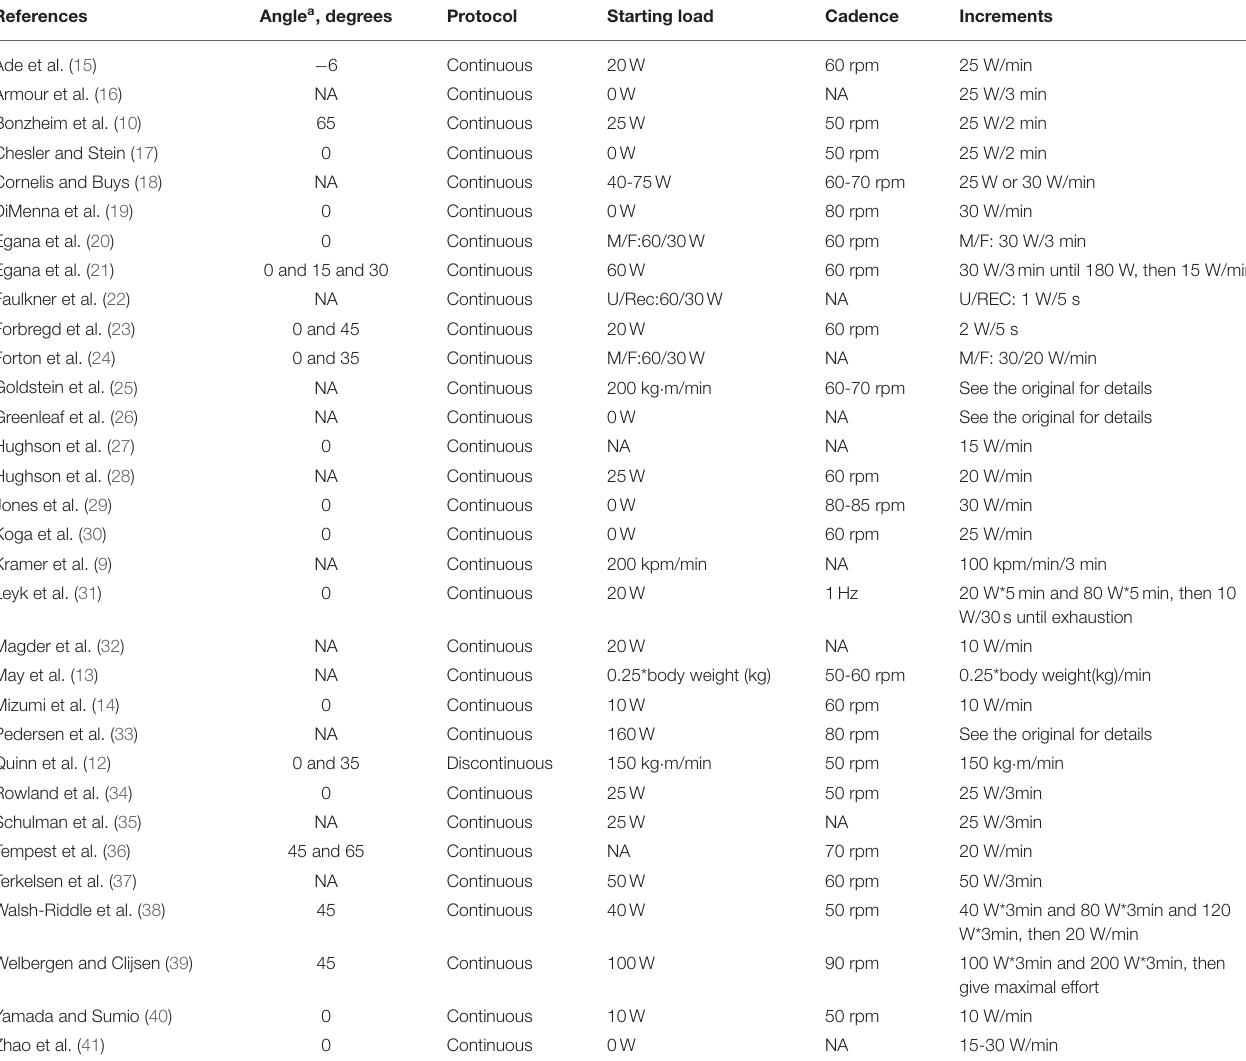
TABLE 3 | Exercise protocol for the included studies ( n =